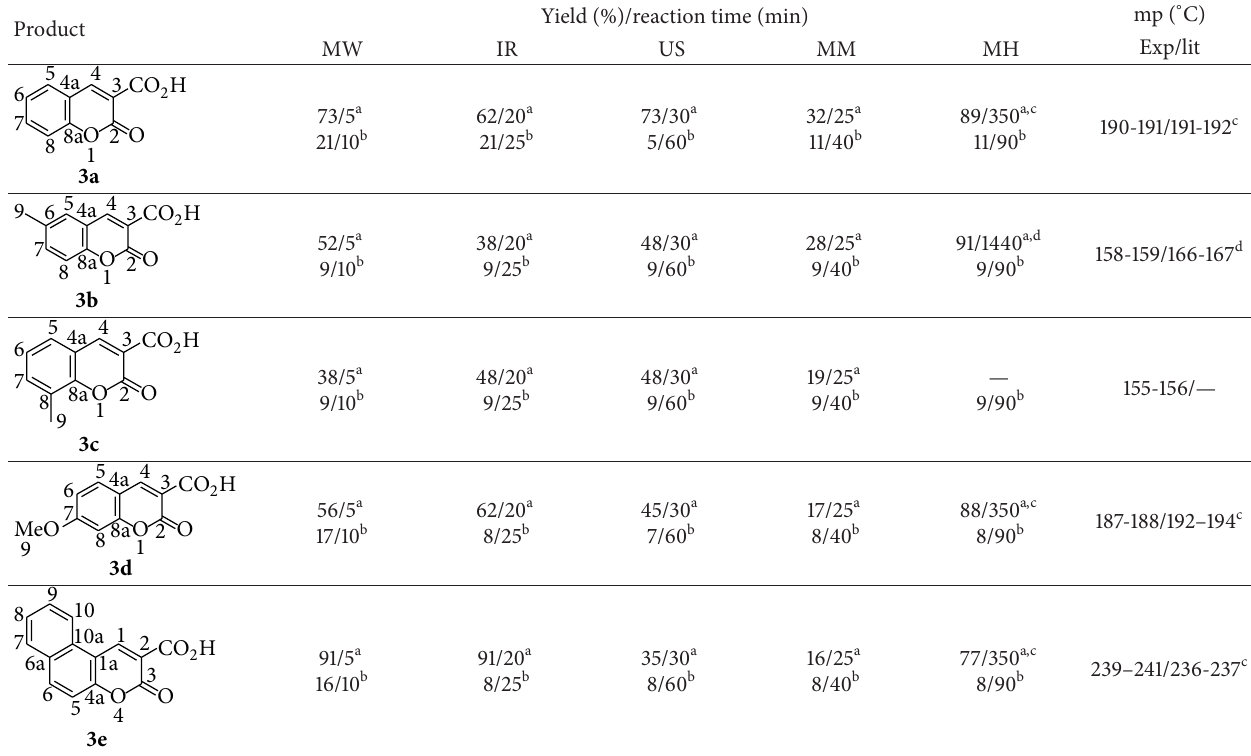
Table 1: Formation of coumarins using five activating